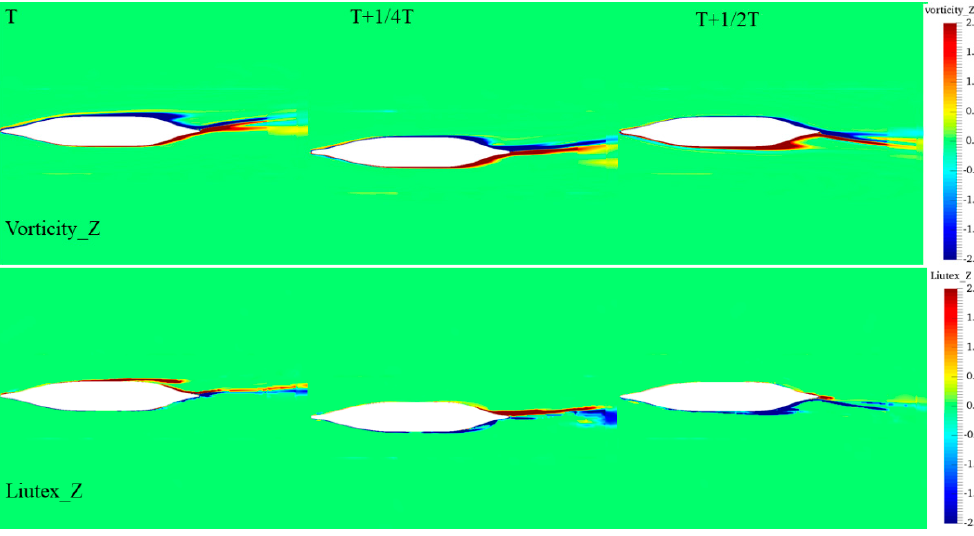
= − 0.03572 in CASE pp